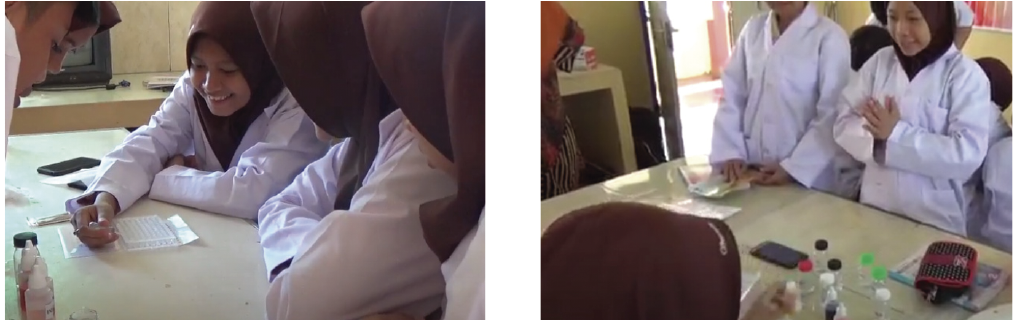
Figure 10. A student’s smile when she tried the tools for the first time, and the joy of another student when she observed color changes and finished